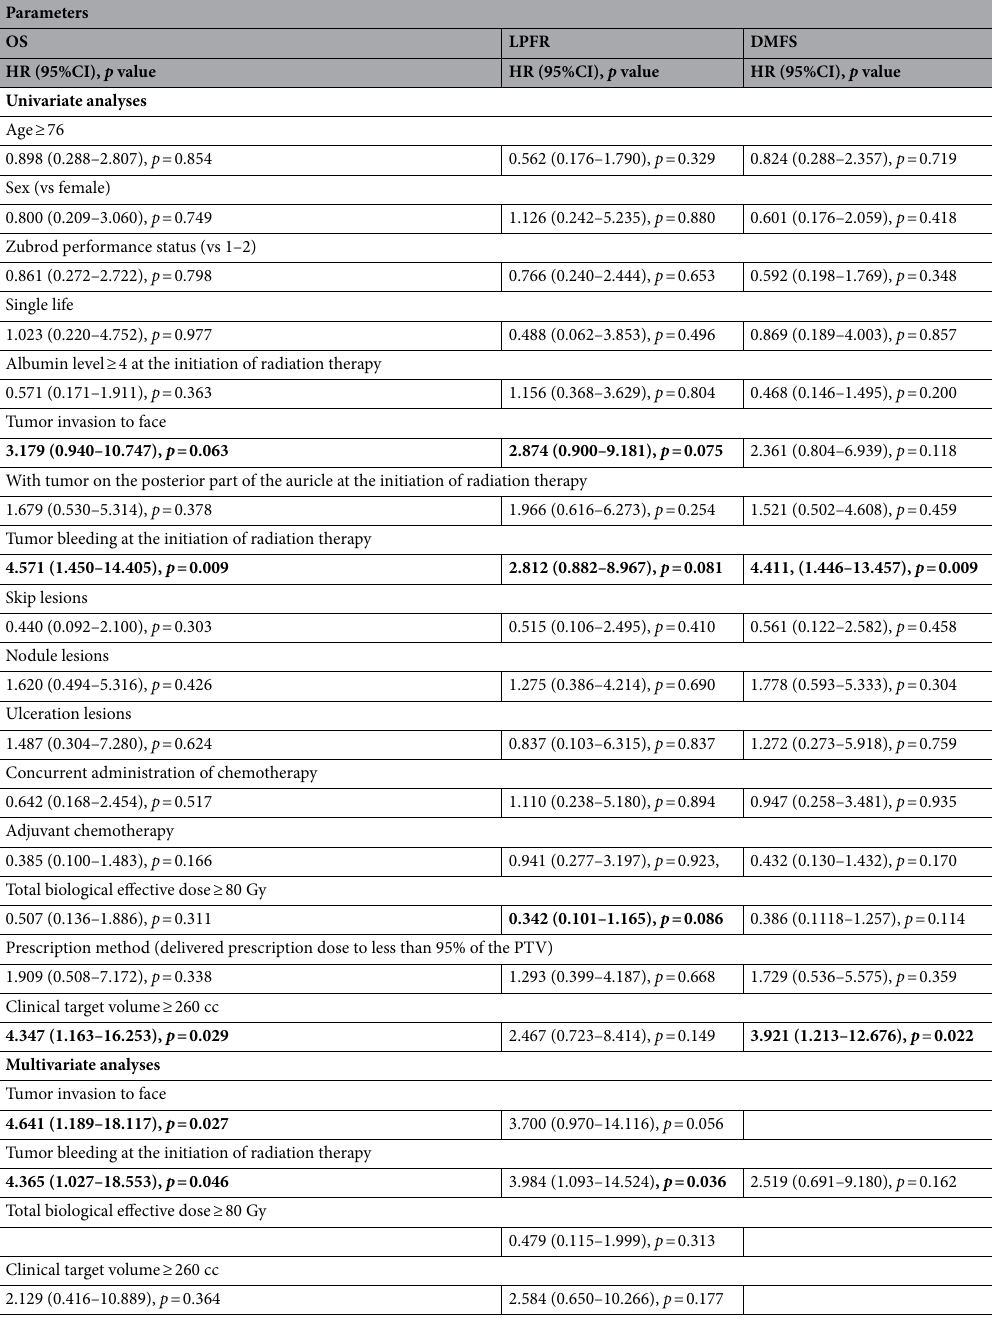
Table 3. The univariate and multivariate analyses of OS, LPFR, and DMFS. OS*, overall survival, LPFR † ; local progression-free rate, DMFS ‡ ; distant metastases-free